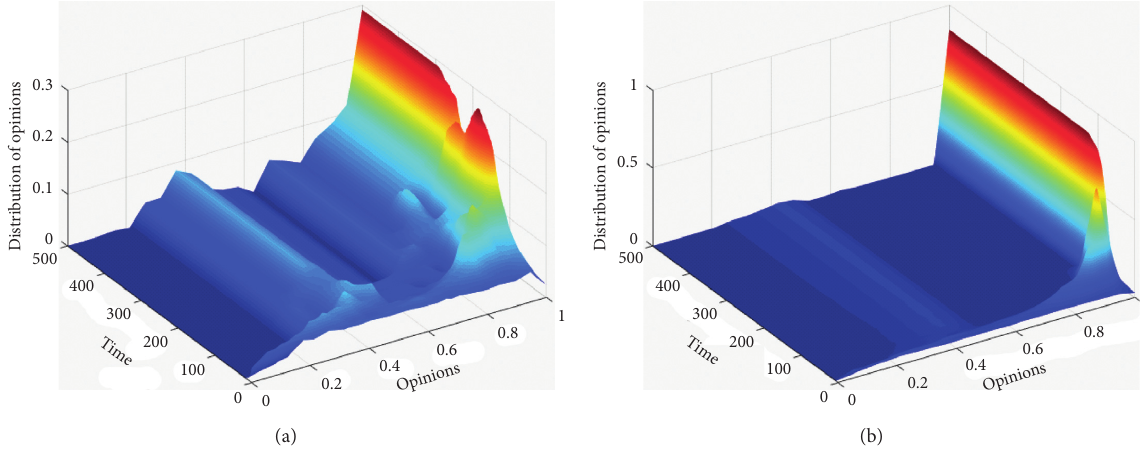
Figure 7: Group opinion distribution evolution in the random network. Group polarization is formed when d (b) d m � 0 . 6.